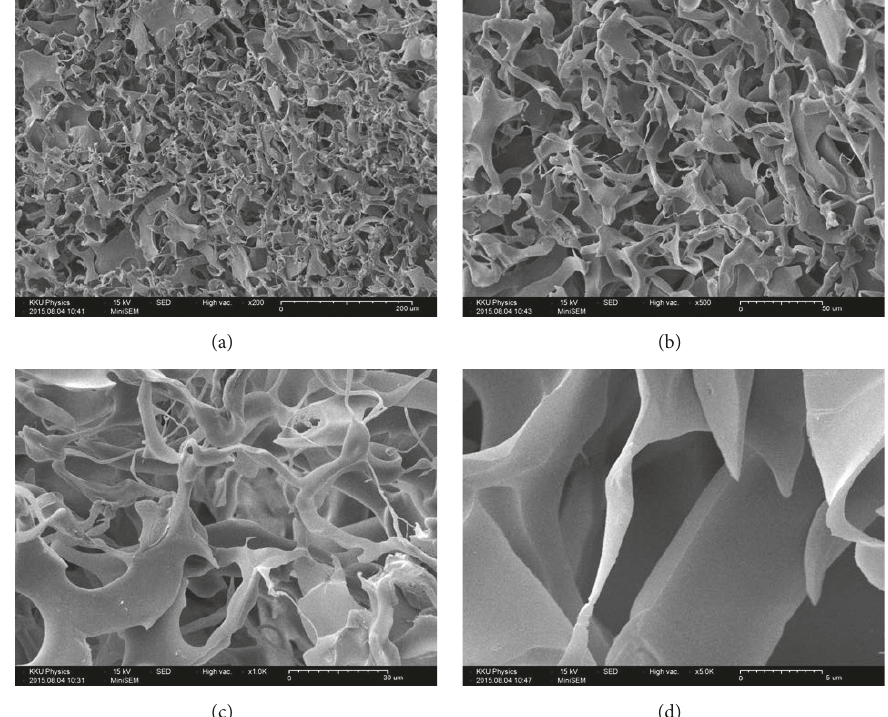
Figure 2: Surface morphology of dextran from W. confusa R003 by scanning electron microscopy (SEM): (a) 200x; (b) 500x; (c) 1000x; (d)